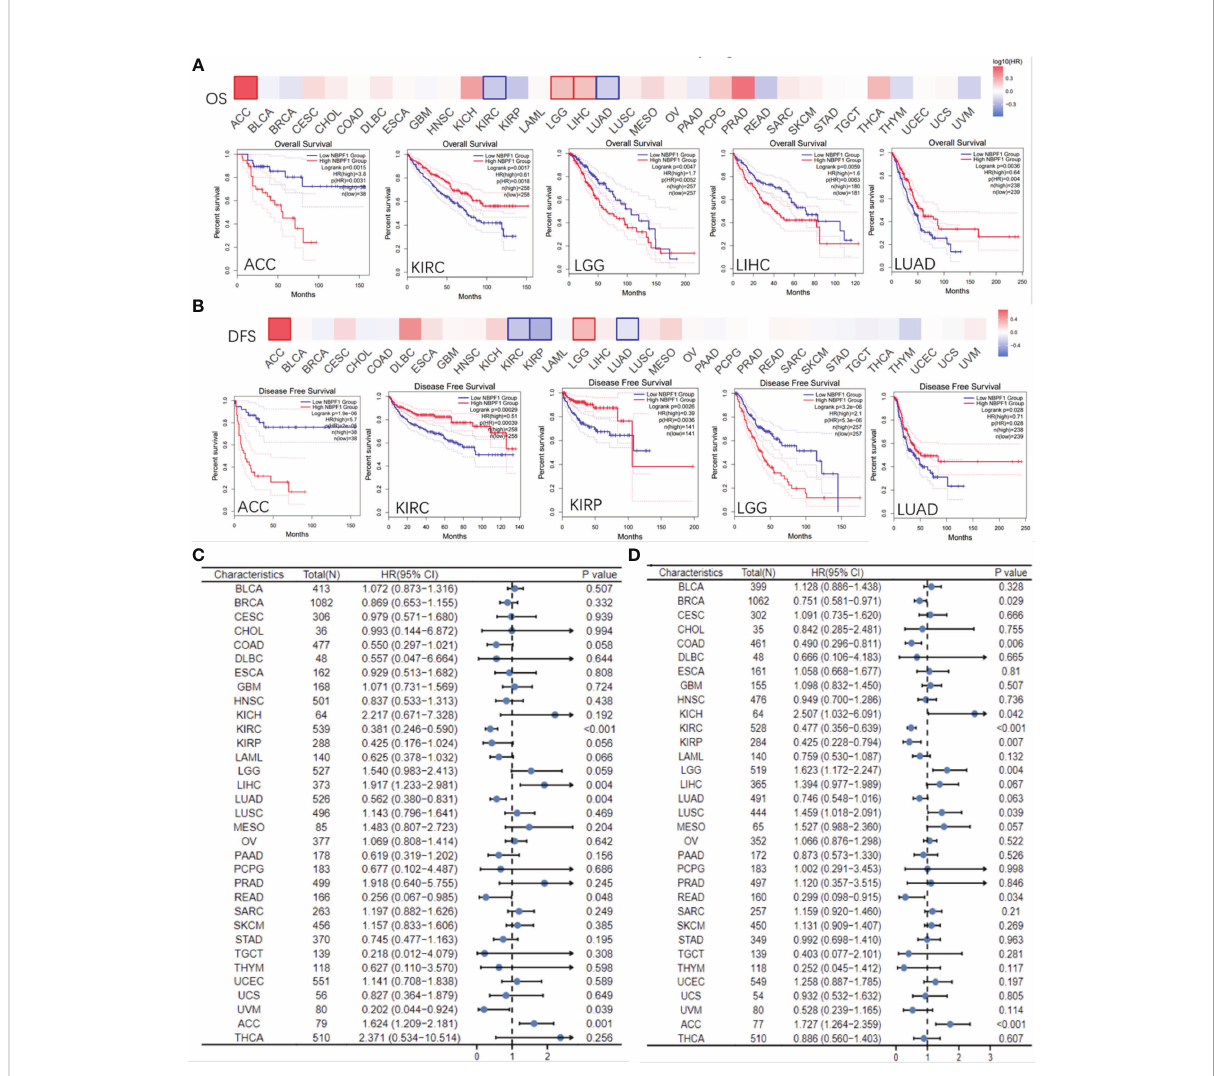
FIGURE 4 Prognostic value of NBPF1 in human cancers. KM curves and heatmap showing the relationship between NBPF1 gene expression levels and (A) overall survival and (B) disease-free survival taken from the GEPIA2 database. Forest plots of pan-cancer univariate Cox regression analyses of (C) overall survival and (D) disease-speci fi c